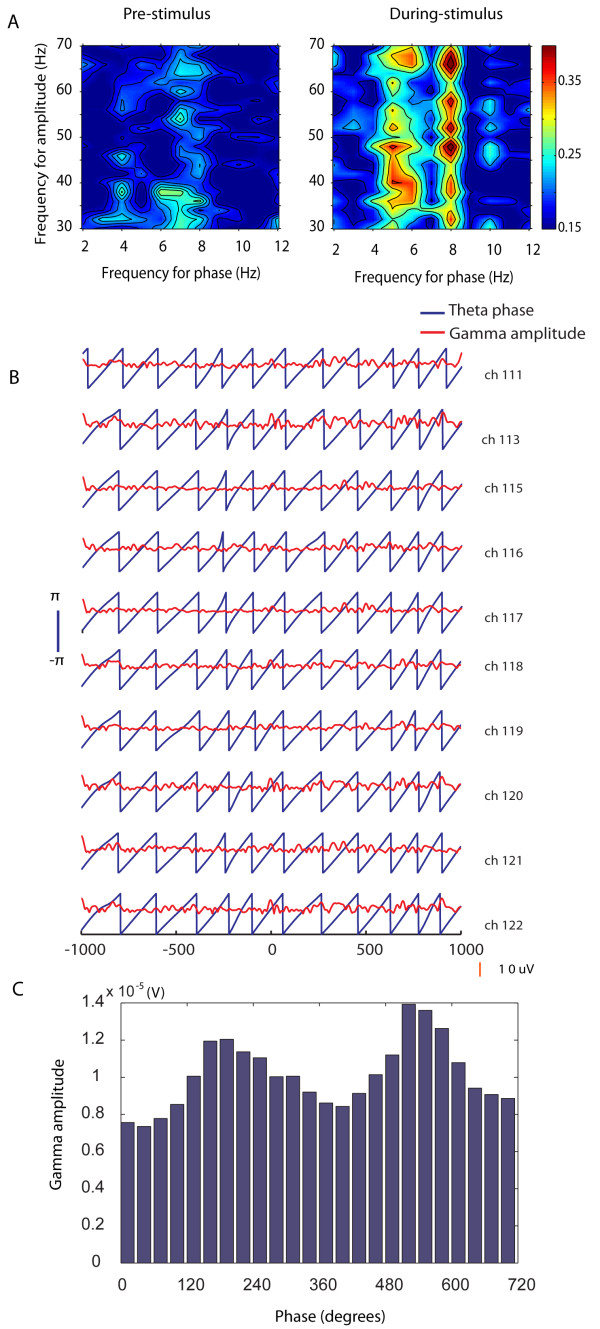
Theta-gamma coupling in IT. (A) shows a typical example of coupling between theta phase and gamma amplitude taken from Sheep B (session 110305-1, channel 3) for the pre-stimulus (left) and during-stimulus (right) periods before (left) and during (right) presentation of a learned stimulus pair. There is a clear increase in coherence (represented by pseudocolor scale) across the entire gamma range and parts of the theta range (particularly at 8 Hz) and no evidence for coupling with gamma at phase frequencies immediately below or above the theta band. The red/yellow areas indicate where coupling between the two frequencies was significant (p < 0.001). (B) Shows typical data from 10 adjacent individual channels (from same sheep and recording session as in (A)) which exhibited significant (p < 0.001) coupling between theta phase and gamma amplitude across a 1 s before and a 1s period during stimulus presentation. Peaks in gamma amplitude (red) can clearly be seen across the electrodes during the majority of the theta cycles displayed. These data also illustrate the strong synchronization of theta phase across individual channels. Patterns of gamma amplitude changes are also very similar across the electrodes. (C) Shows an example of the strength of coupling between theta phase and gamma amplitude for a single channel across two theta cycles. It can be seen that there is consistently stronger locking at around 180 degrees in both cycles.